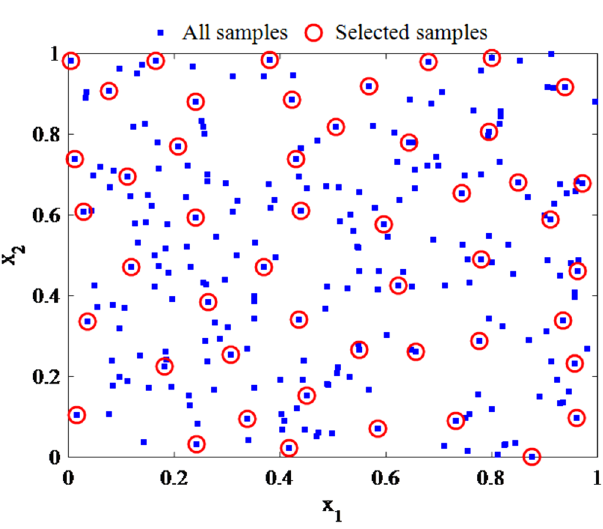
Figure 1. Plot of the data splitting pattern using Kennard–Stone algorithm on 245